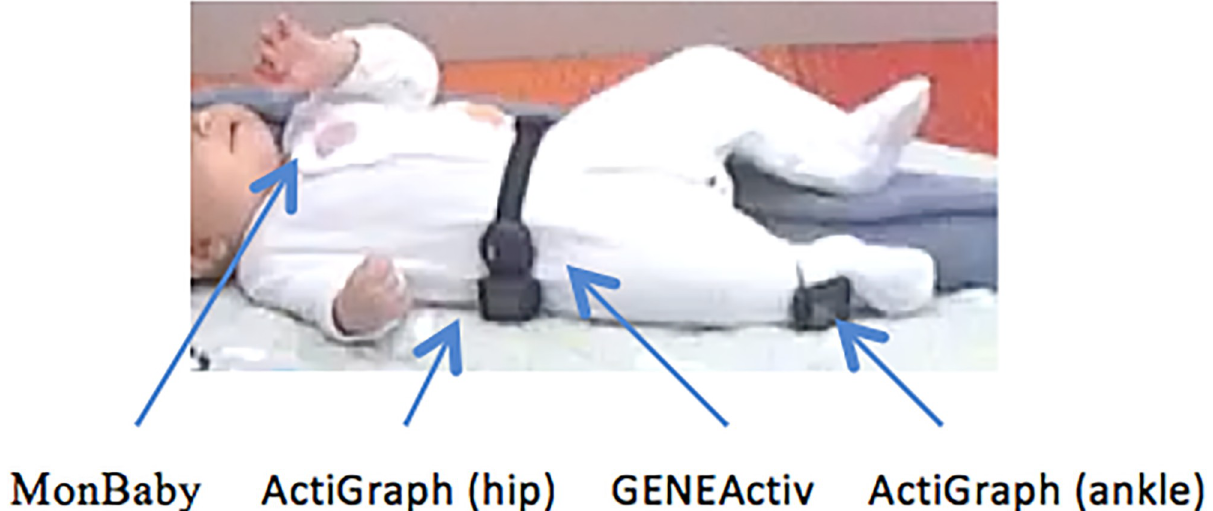
Fig 1. Device placement on infants. 14-week-old female wearing four devices as indicated. The parent of the individual in this manuscript has given written informed consent (as outlined in PLOS consent form) to publish these case